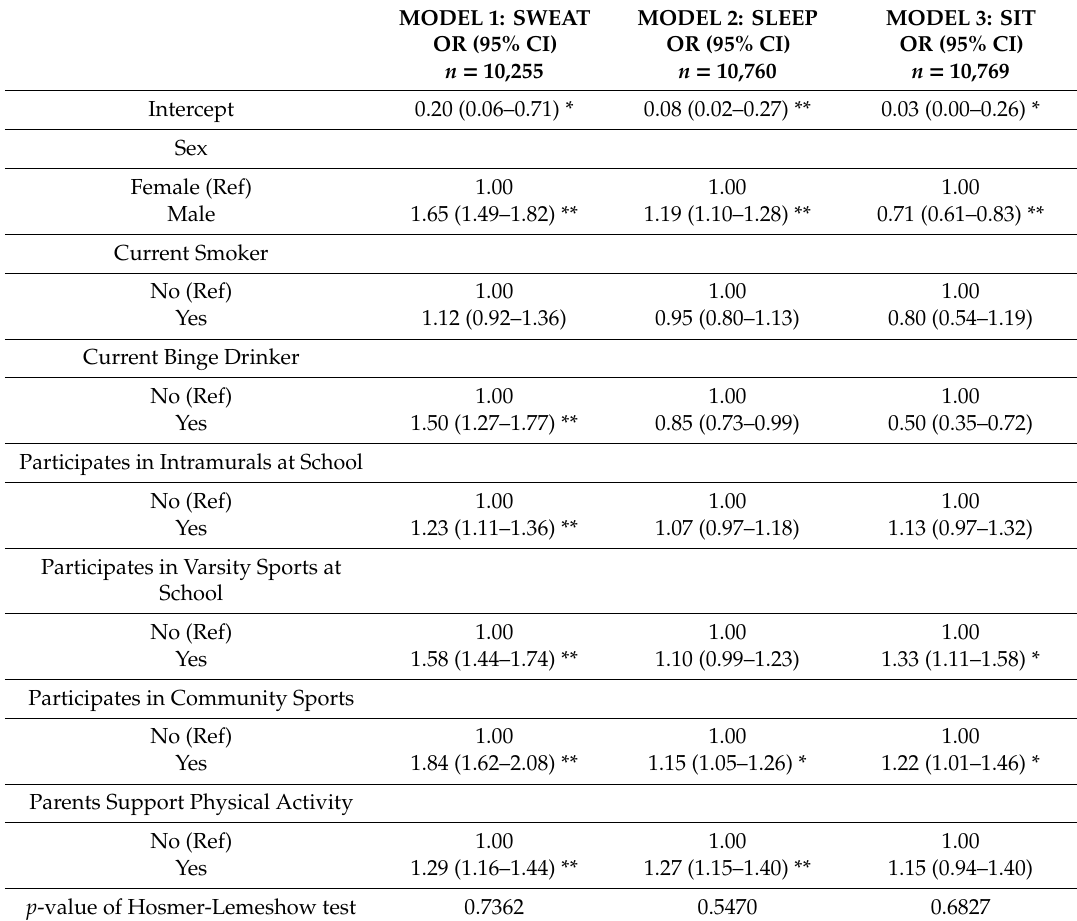
Table 2. Two-level logistic regression models examining the probability of meeting the di ff erent 24-Hour Movement Guideline (24-MG) recommendations within the cross-sectional COMPASS Year 2 (2013–2014) grade 9 student